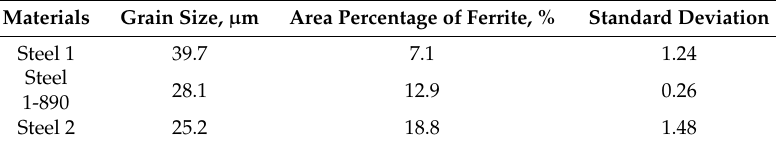
Figure 5. Metallographic structures of steel 1 ( a ), steel 2 ( b ), and steel 1-890 ( c ). Table 3. Area percentage of ferrite and grain size in hot-rolled materials. Table 3. Area percentage of ferrite and grain size in hot-rolled materials.